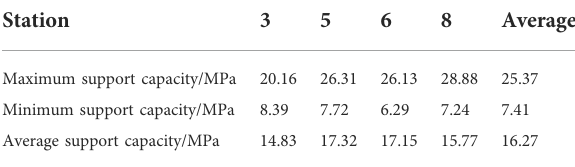
TABLE 1 Maximum, minimum, and average support capacities at each fi eld measurement